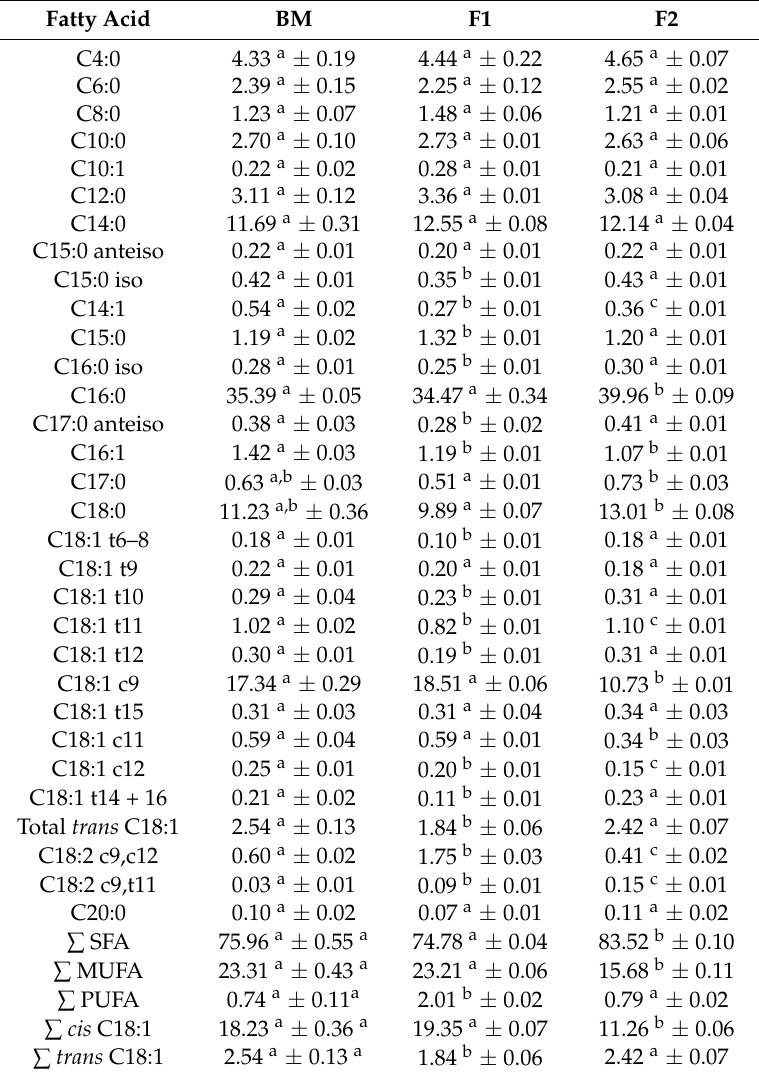
Table 1. Fatty acid composition (mean values and standard deviations) of buttermilk (BM) and isolated lipid fractions F1 and F2 (in %), as determined by